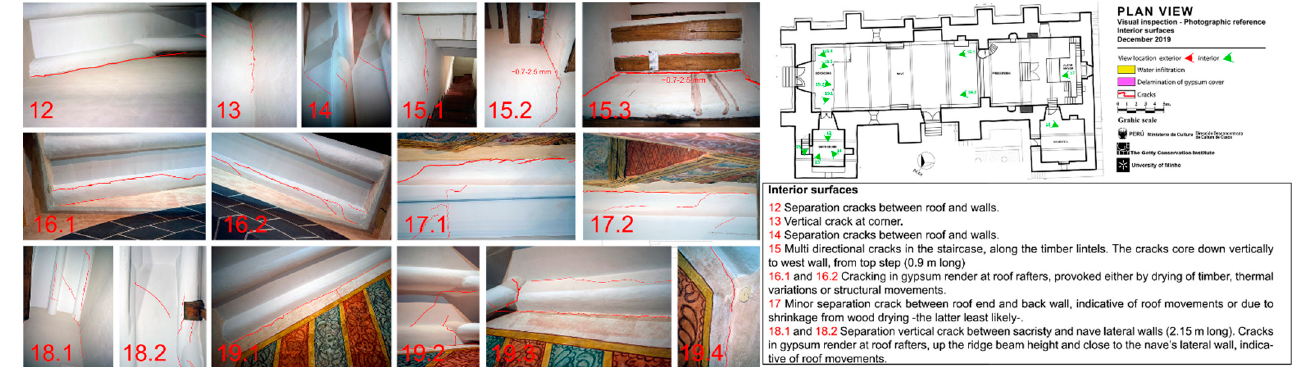
Figure 9. Set of documented damages comprised of thin cracks, at wall intersections, and for the roof’s gypsum finishing in the interior surfaces. Note the photo references in the plan view.